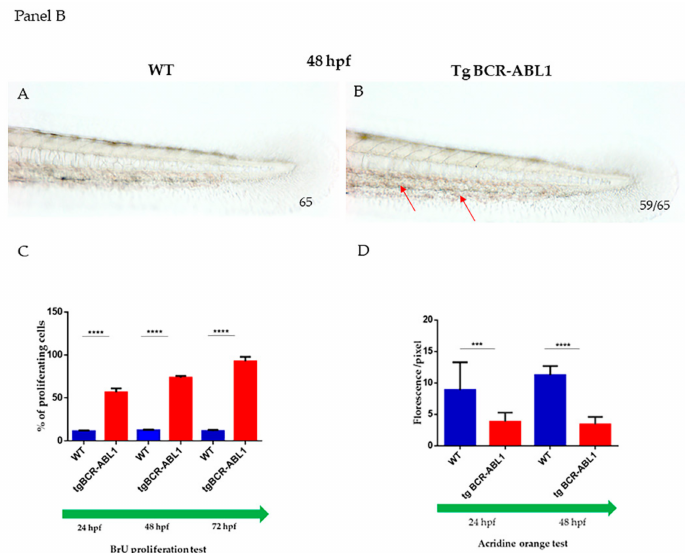
Figure 2. Panel ( A ). ( A , C ) Bright-light images of live wild type (WT) and Tg BCR-ABL1 at 24 hpf; the accumulated hematopoietic cells are indicated in the red box. ( B , D ) The areas in the red boxes are shown at higher magnification (12.5 X). The region (boxed) of posterior blood islands is enlarged and show the immunofluorescence staining of phospohistone3. All the experiments were performed at least in triplicate; images show one representative experiment. Numbers in each panel represent total embryos used for the experiment and embryos with the phenotype shown in the image. ( E ) Immunostaining with phospohistone 3 (PH3) to label cells in M-phase: percentage of PH3 positive cells over the total number cells present in posterior blood islands. (Magnification 7X A, C; 12.5 X B, D) Blue bar represents wild type; red bar represents Tg BCR-ABL1. Statistical analysis was performed by unpaired, two-tailed T Test **** p < 0.0001. Panel ( B ) ( A , B ) Bright light images of wild type (WT) and Tg BCR-ABL1 at 48 hpf. The images show a particular of the caudal hematopoietic tissue (CHT). Red arrows indicate cells accumulated in CHT. ( C ) The graph of BrdU staining show the percentage of proliferating cells in WT and Tg BCR-ABL1 at 24, 48 and 72 hpf; ( D ) Quantification of the fluorescence of embryos at 24 and 48 hpf shown in Figure S3 acquired by ZF-Mapper software. Blue bar represents wild type; red bar represents Tg BCR-ABL1. All the experiments were done at least three times. Unpaired, two-tailed t -test *** p < 0.001, **** p < 0.0001.